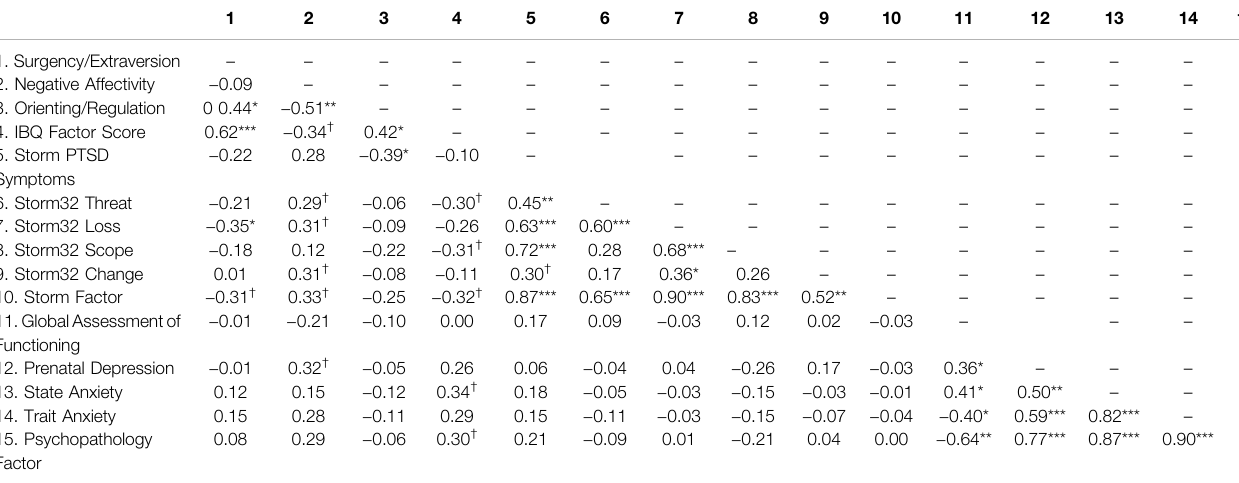
TABLE 2 | Correlations among variables of